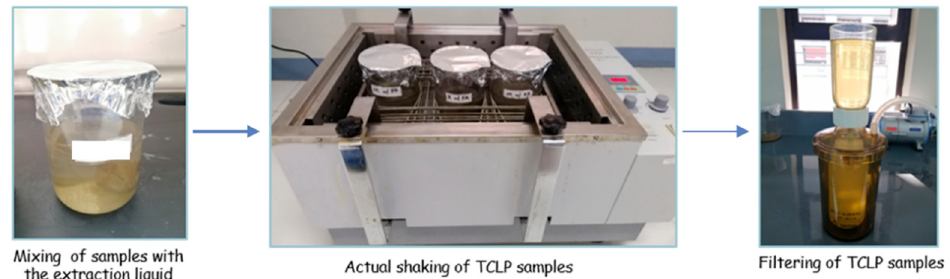
Figure 1. A schematic diagram of the TCLP setup.